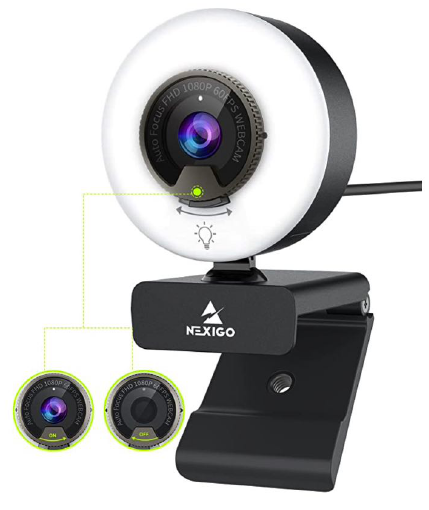
Figure 2. Nexigo webcam (model